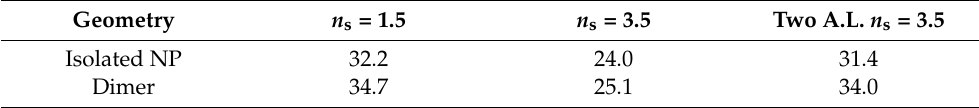
Table 2. Fraction of radiation scattered into the substrate, f subs , integrated over the spectral range λ ∈ [800–1500] nm for the different analyzed particle configurations. We show the cases correspond- ing to two monolayer substrates made of SiO 2 ( n s = 1.5) and silicon ( n s = 3.5) and a multilayer substrate constituted by two antireflection layers (A.L.) on a silicon